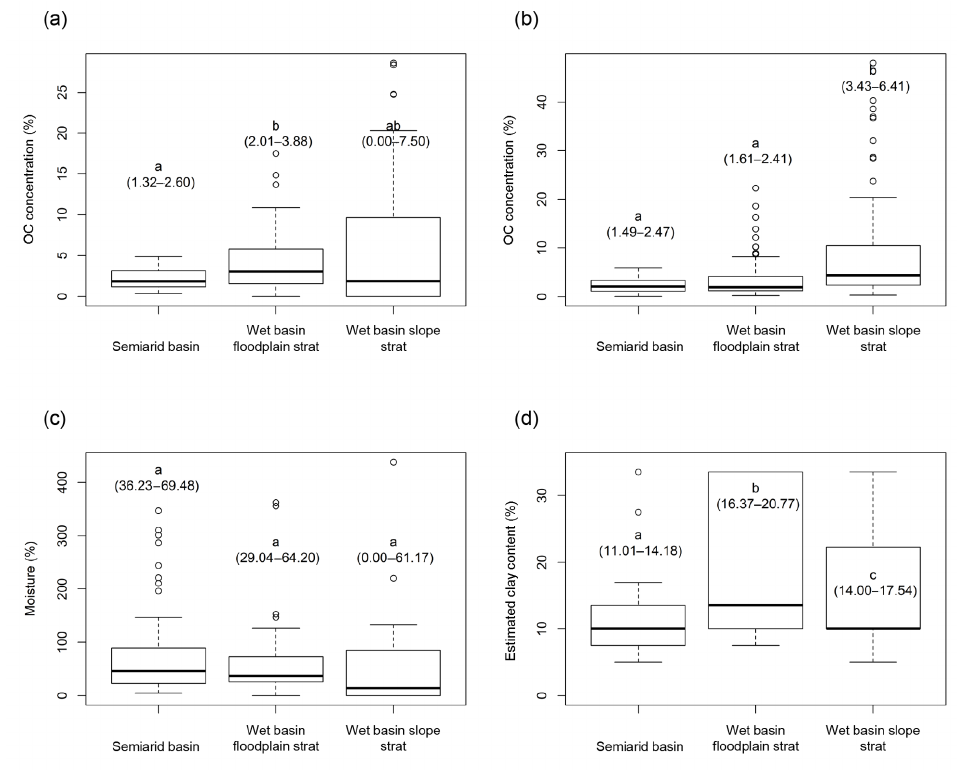
Figure 2. Box plots showing comparisons between model groups of OC concentration at the reach scale (a) , OC concentration at the scale of individual soil samples (b) , moisture at the reach scale (c) , and estimated clay content at the scale of individual soil samples (d) . Ends of dotted lines represent 1.5 times the interquartile range, which is represented by boxes. Bold line represents median. Circles represent outliers. Letters indicate probable differences between groups based on pairwise Wilcoxon (a–c) or t tests (d) with a Holm correction. Ranges in parentheses below letters show the 95% confidence interval of the median value for the group (a–c) or the mean value for the group (d) in which median confidence intervals were overly constrained due to the categorical nature of our estimated clay content